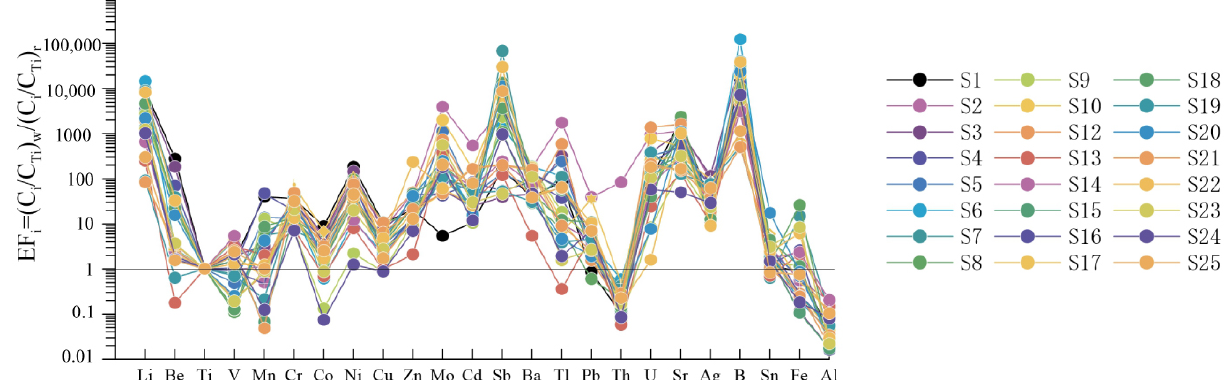
Figure 5. Trace element distribution in terms of enrichment coefficient (weight ratios) normalized to Ti for waters of the XJF.